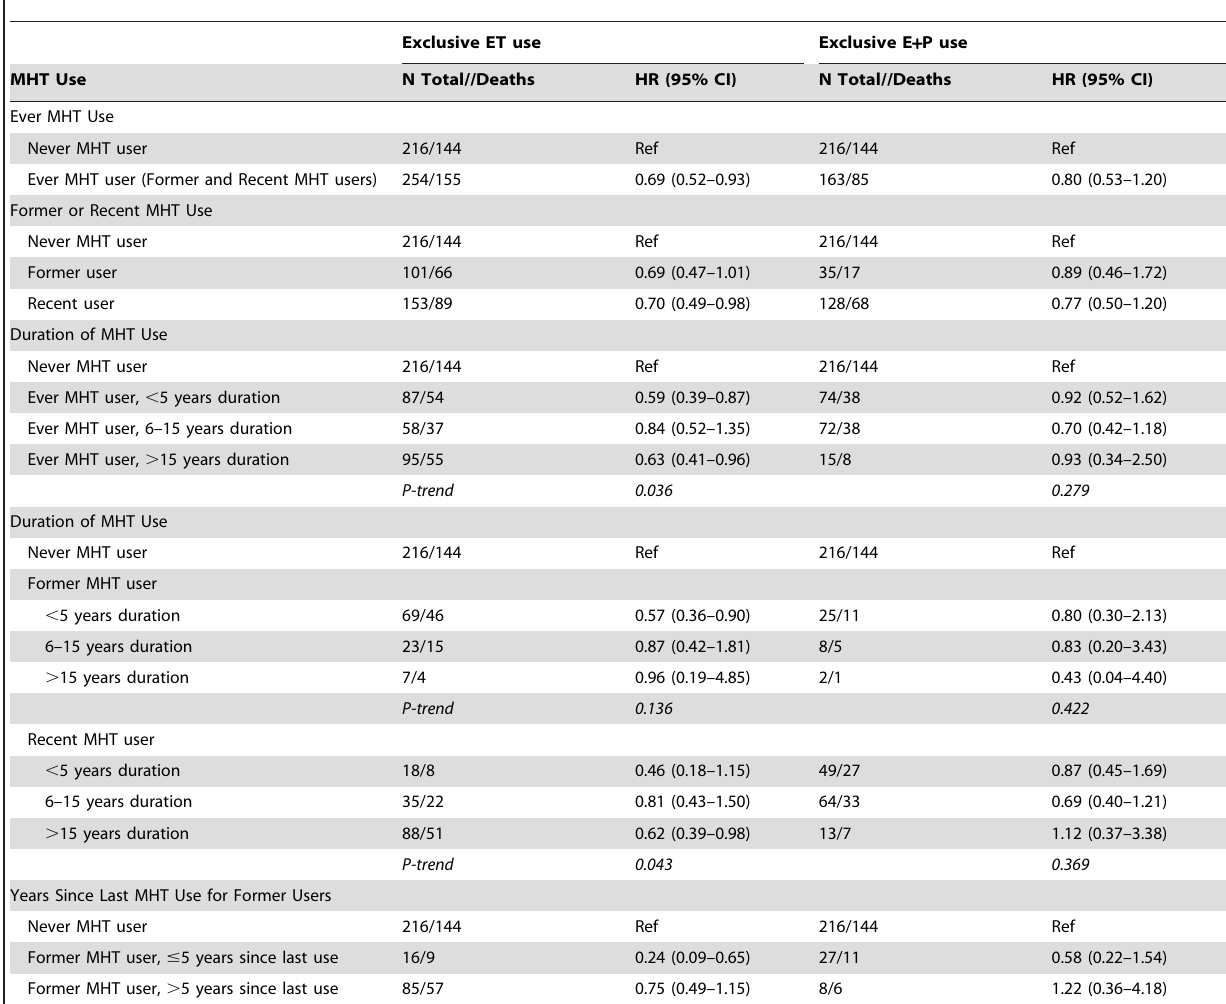
Table 3. Adjusted 1 hazard ratios (HR) and 95% confidence intervals (CI) for the association between menopausal hormone therapy (MHT) use and mortality among 727 postmenopausal women with diagnosed with lung cancer after enrollment in the California Teachers Study stratified by MHT